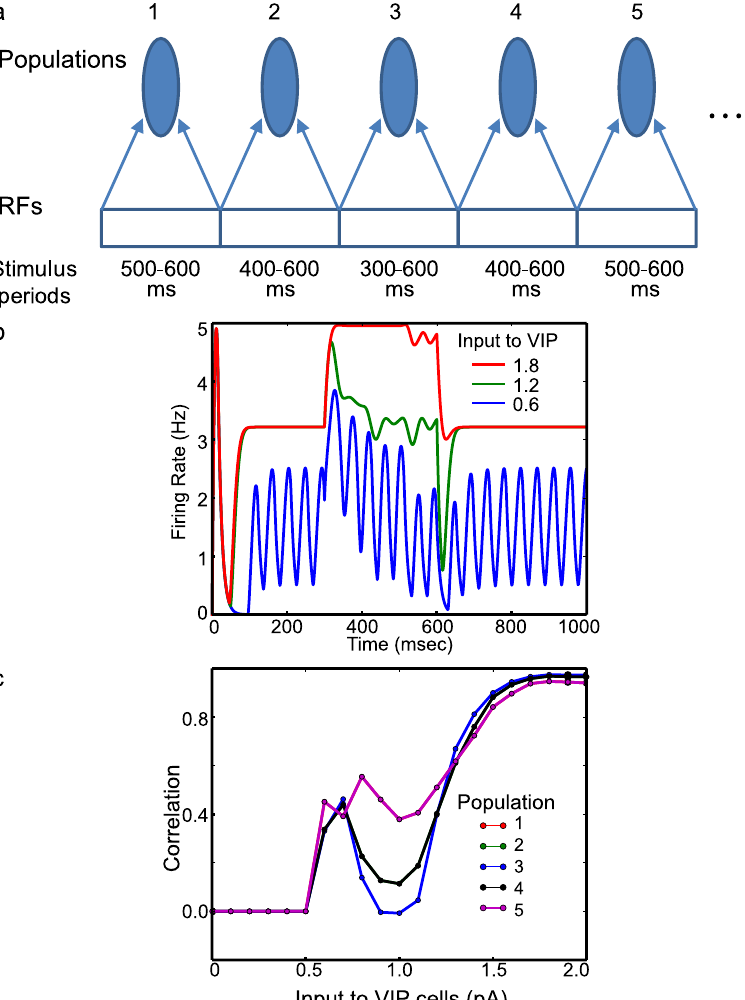
Figure 5. The effects of VIP cell depolarization on responses to the object growing in size. ( a ) Method by which we simulate the object growing in size. ( b ) Pyr cell activity in population 4 between low (0.6 pA) and high (1.8 pA) input to VIP cells. For comparison, Pyr cell activity with the intermediate input (1.2 pA) to VIP cells is also displayed. ( c ) Dependency of population specific correlations between the stimulus inputs and Pyr cell responses on the input to VIP cells. Populations are distinguished using different colors. As populations 2 and 4 (1 and 5) show identical responses, only three lines are visible in ( c